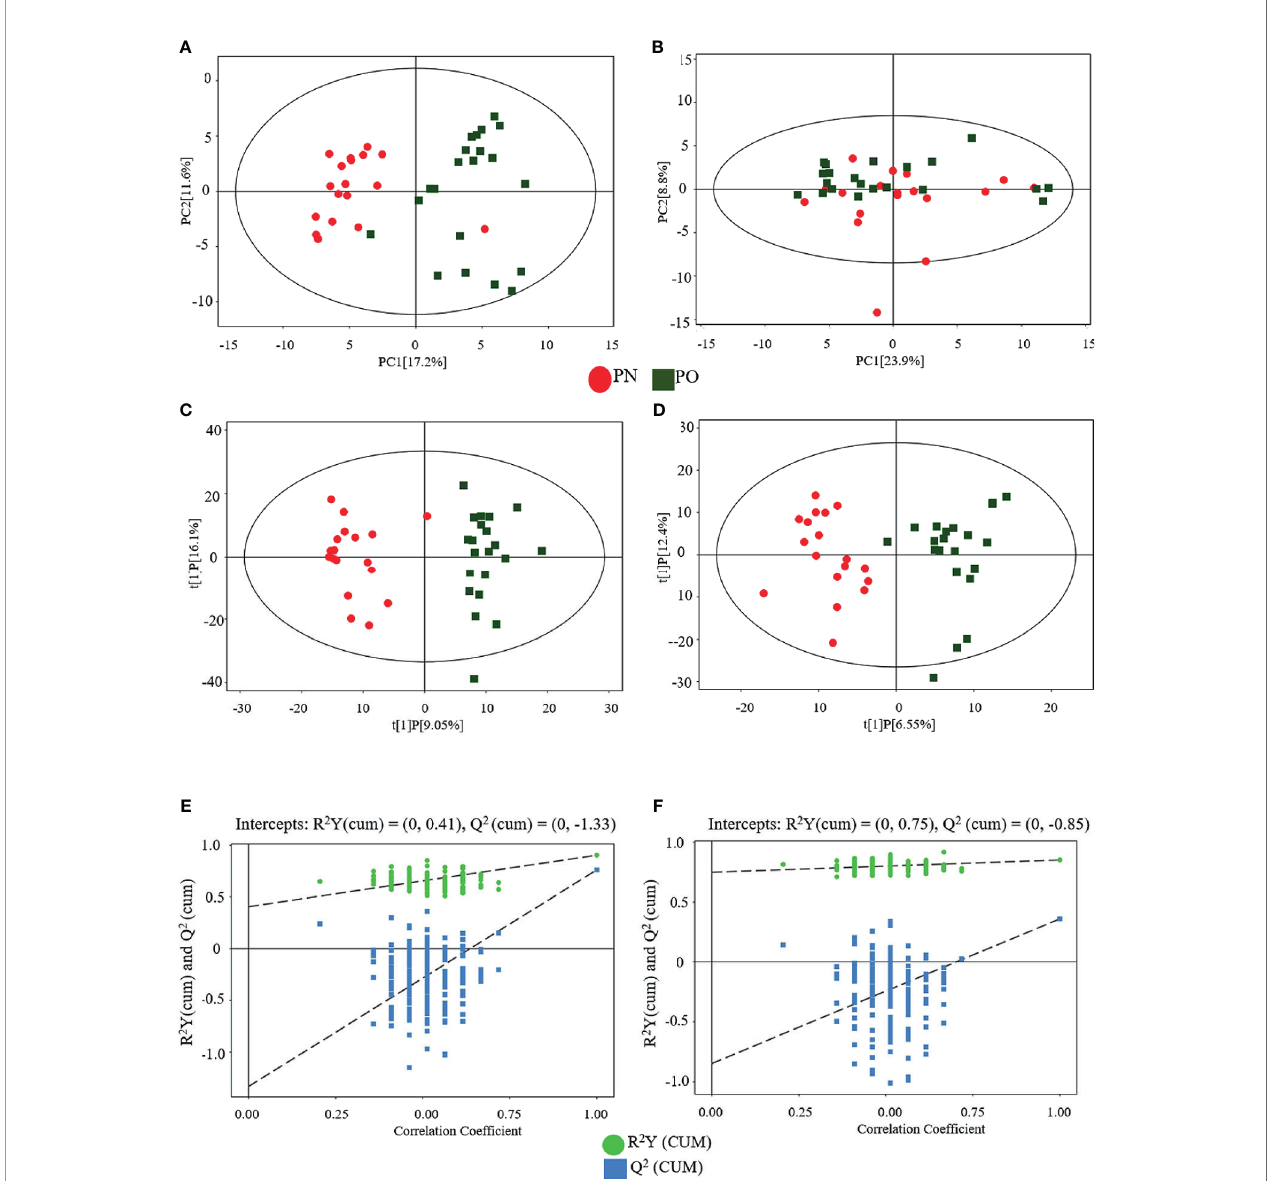
FIGURE 2 | Multivariate analyses of serum metabolites. (A) PCA (POS); (B) PCA (NEG); (C) OPLS-DA (POS); (D) OPLS-DA (NEG); statistical validation of OPLS-DA model, (E) (POS) and (F)